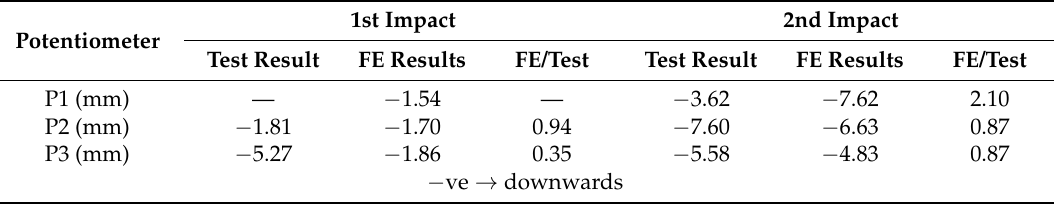
Table 12. Summary of the settlements of the multi-layer slab from both numerical and experiment results.